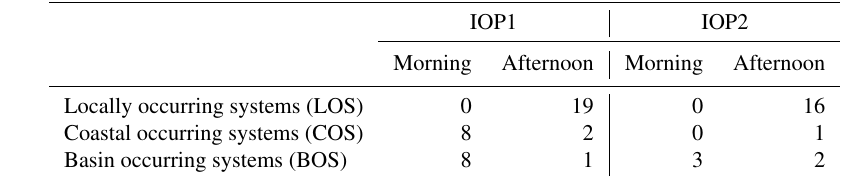
Table 1. Number of convective systems identified in the morning and afternoon during IOP1 and IOP2.